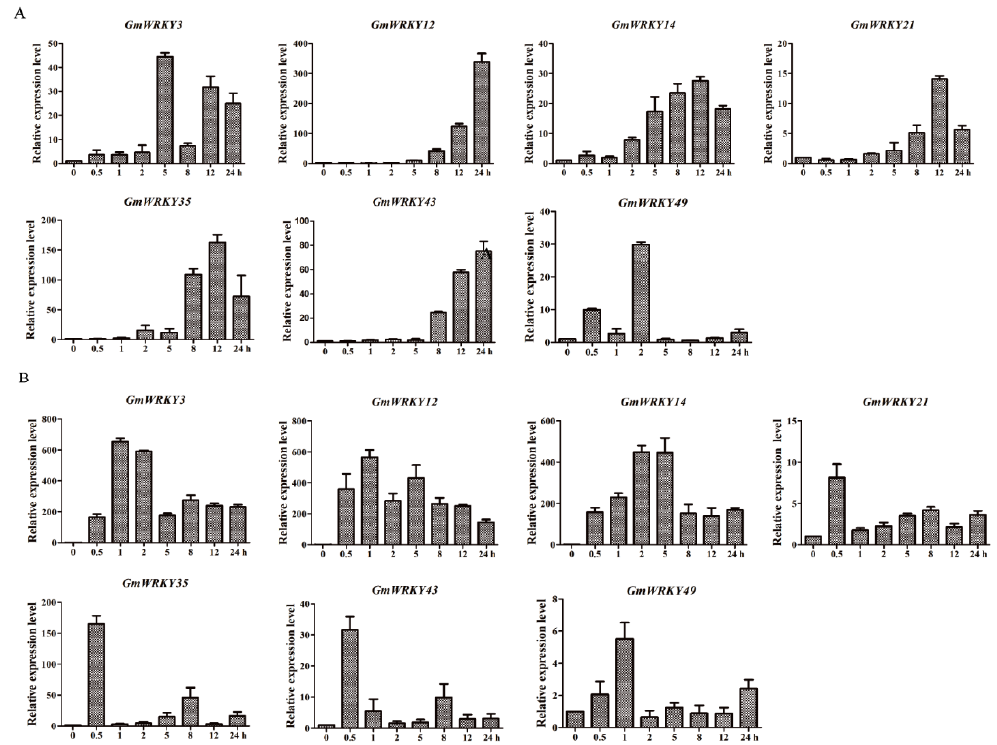
Figure 3. Quantitative RT-PCR of seven GmWRKYs under drought and salt treatment. ( A ) qRT-PCR of seven GmWRKYs under drought treatment. ( B ) qRT-PCR of seven GmWRKYs under salt treatment. The expression level of GmActin as a loading control. The data represent means ± SD of three biological replications.